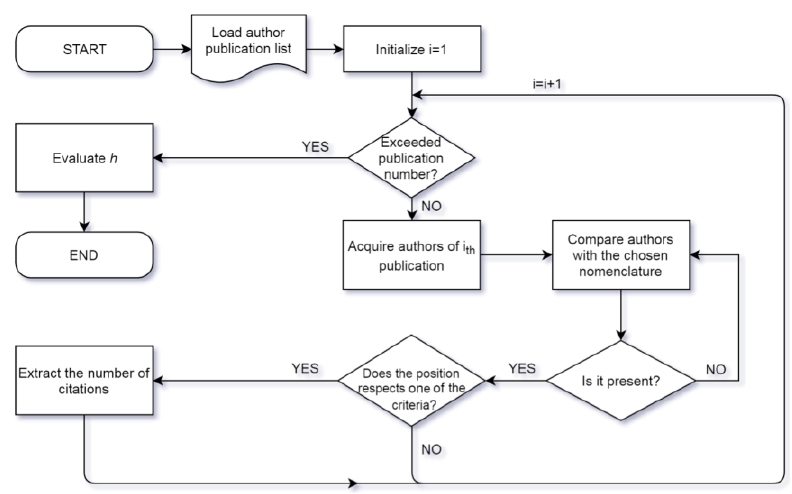
Figure 1. Flowchart of the process to obtain the corrected h-value.